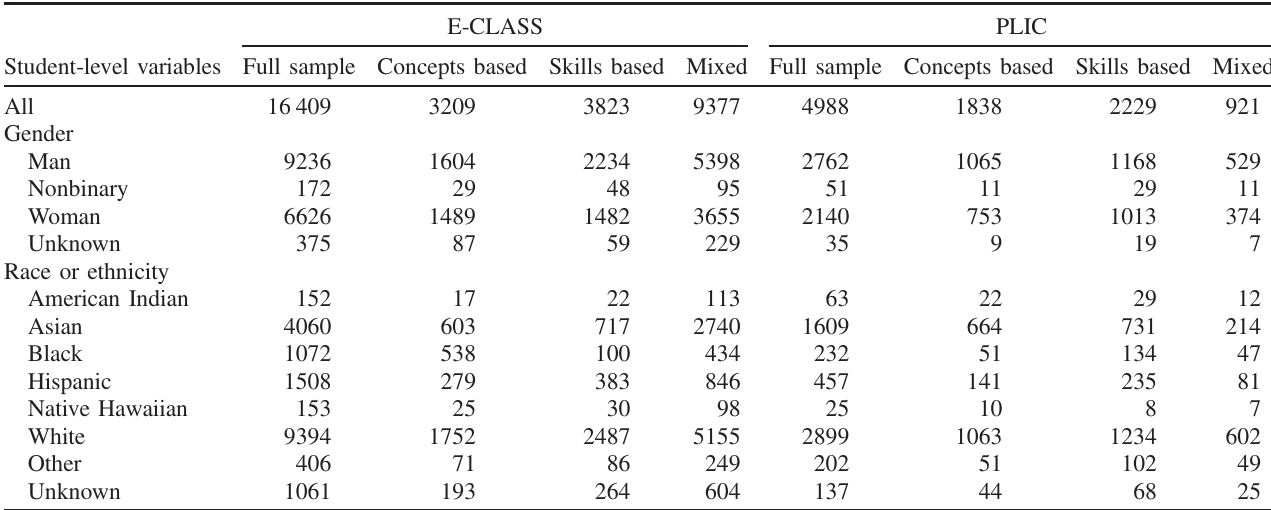
TABLE II. Demographic breakdown of students in the E-CLASS and PLIC datasets across lab type. Racial or ethnic groups were not considered mutually exclusive and so numbers may not sum to the total number of students in the